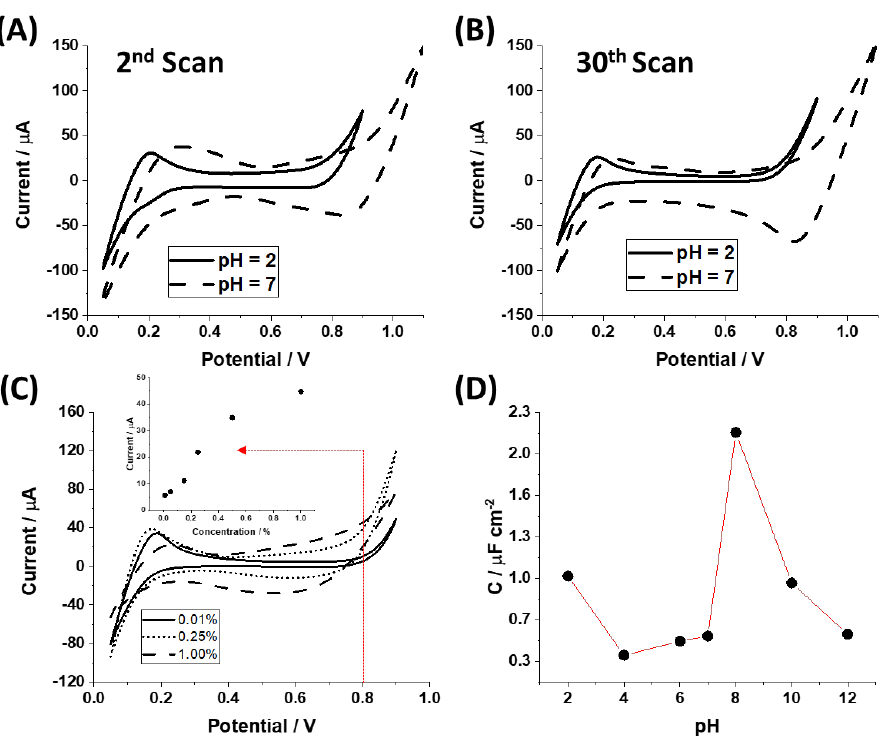
Figure 2. Ion transfer voltammograms (ITVs) recorded for 0.5% TBOT initially dissolved in the organic phase at pH of the aqueous phase equal to 2 (solid line) and 7 (dashed line) for the 2nd ( A ) and 30th ( B ) scan. ( C ) ITVs recorded for TBOT with the organic phase % concentration equal to 0.01% (solid line), 0.25% (dotted line), and 1.00% (dashed line). The second scan is shown. The inset in section ( C ) corresponds to positive ionic current falling for 0.8 V (indicated with the red, horizontal dashed line) recorded for different organic phase TBOT concentrations. pH of the aqueous phase was equal to 2. ( D ) The specific LLI capacitance derived from the voltammetric data plotted in function of the aqueous phase pH.